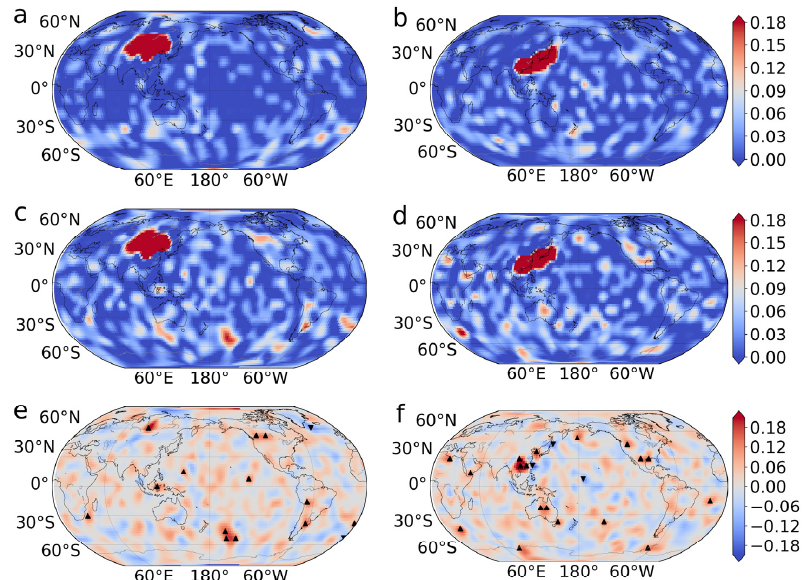
Figure 5. Probability maps of emergence of ( a ) incoming links to the hot spot in East Asia and ( b ) ( b ) outgoing links from the hot spot in East Asia for 1949–1972 years. ( c , d ) The same as ( a , b ), but for 1997–2020 years. The differences of the probability between 1949–1972 and 1997–2020 for ( e ) the incoming link and ( f ) the outgoing link, respectively. The black triangles in ( e , f ) indicate that the differences of the probability between 1949–1972 and 1997–2020 are at least 1/8 (with a 99% significance